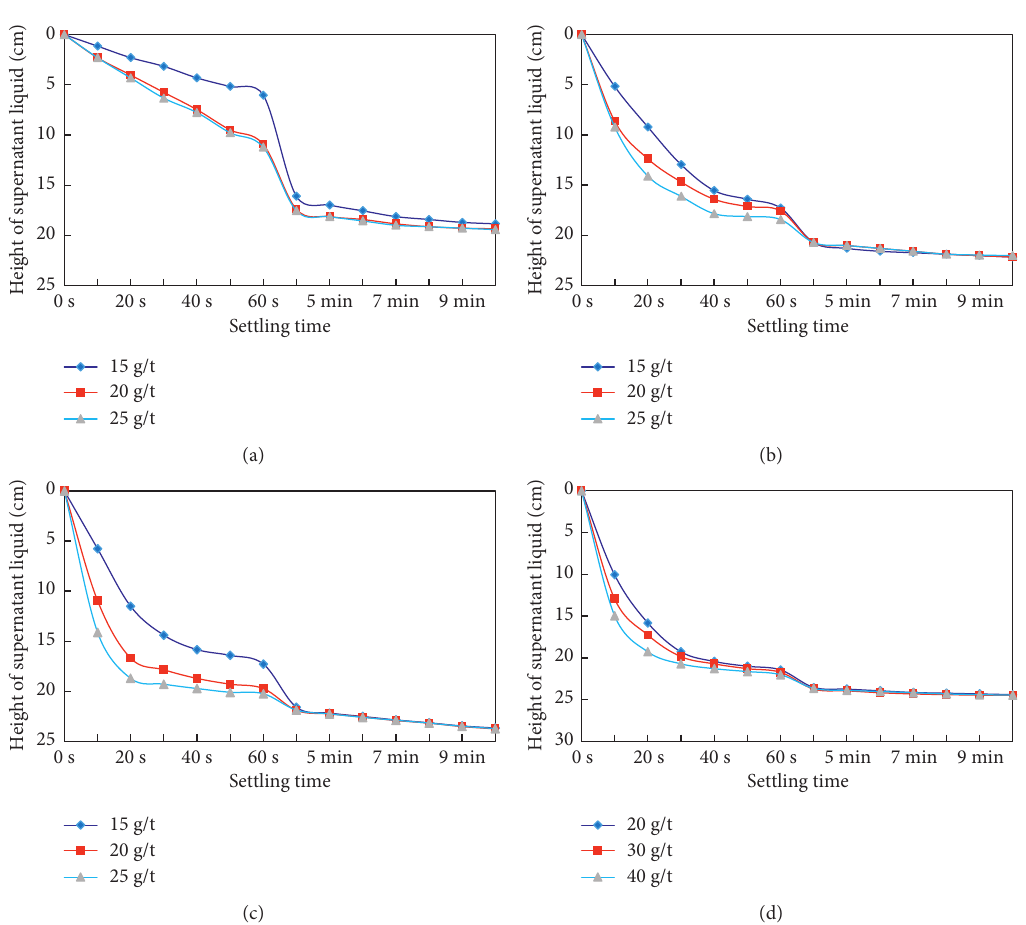
Figure 1: Settlement curves of different tailing slurry concentrations, (a) tailing slurry concentration at 20%, (b) tailing slurry concentration at 16%, (c) tailing slurry concentration at 13%, and (d) tailing slurry concentration at